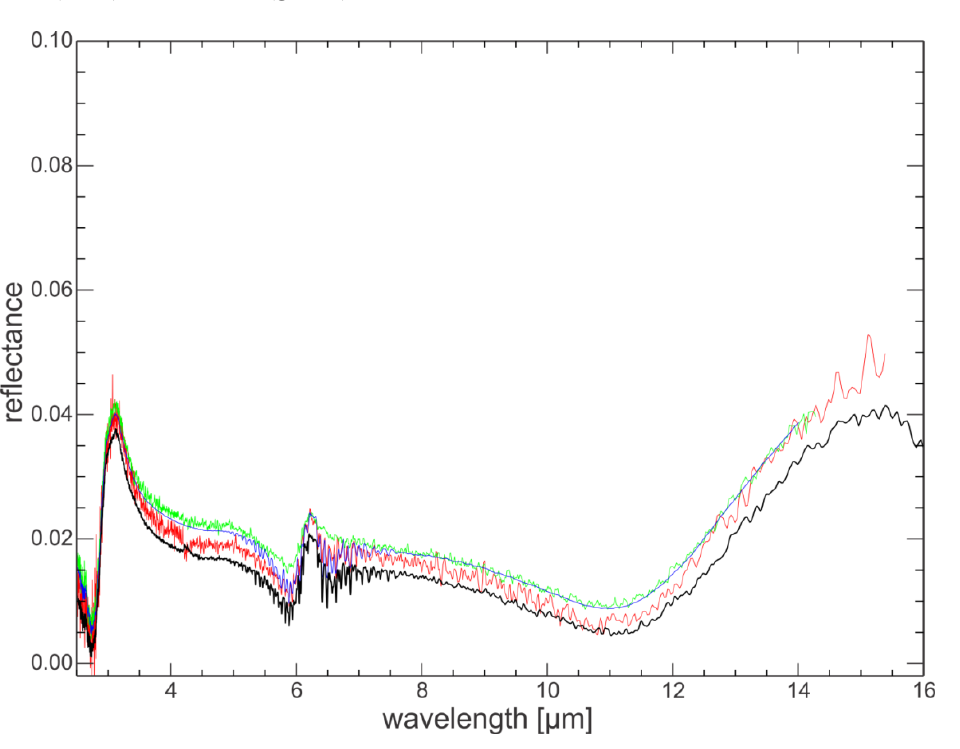
Figure 9. Spectra of demineralized water measured by UT-ITC (black), compared to JPL (red), JHU (blue) and USGS